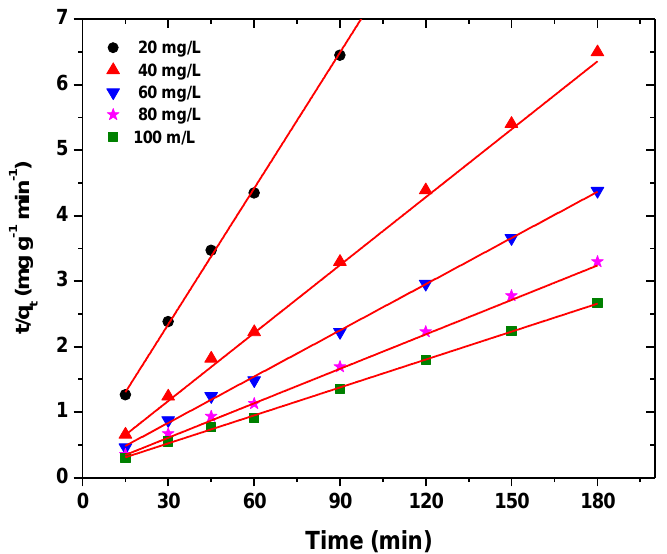
Figure 13. Pseudo-second-order model for dye adsorption by BFO/CFO@PEG nanocomposites. Experimental condition: initial dye concentration 20–100 mg/L, initial solution pH 2, adsorbent dosage 0.06 g/L, and contact time 40 min.